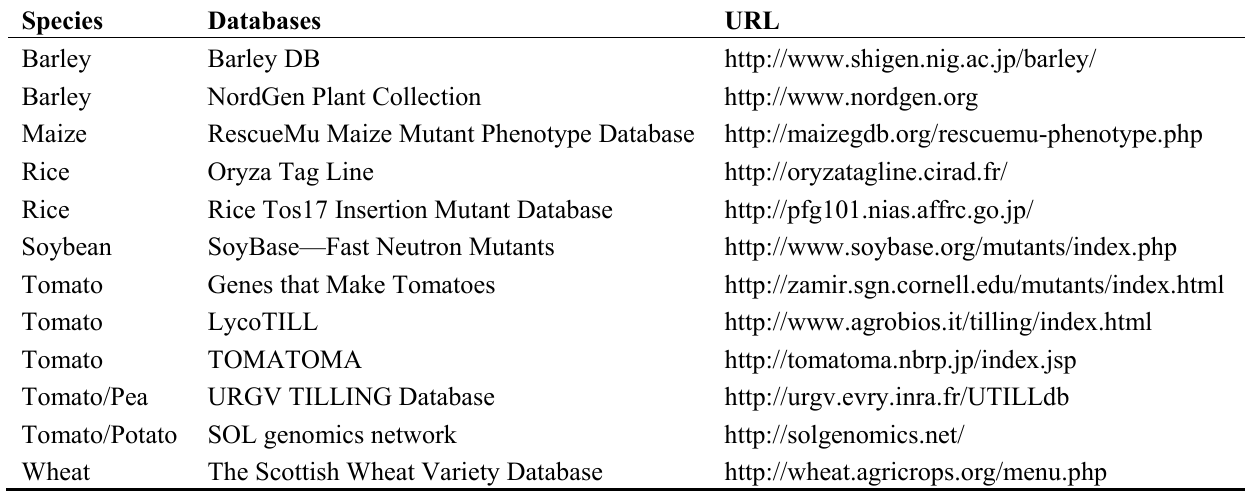
Table 8. Databases for mutant and germplasm